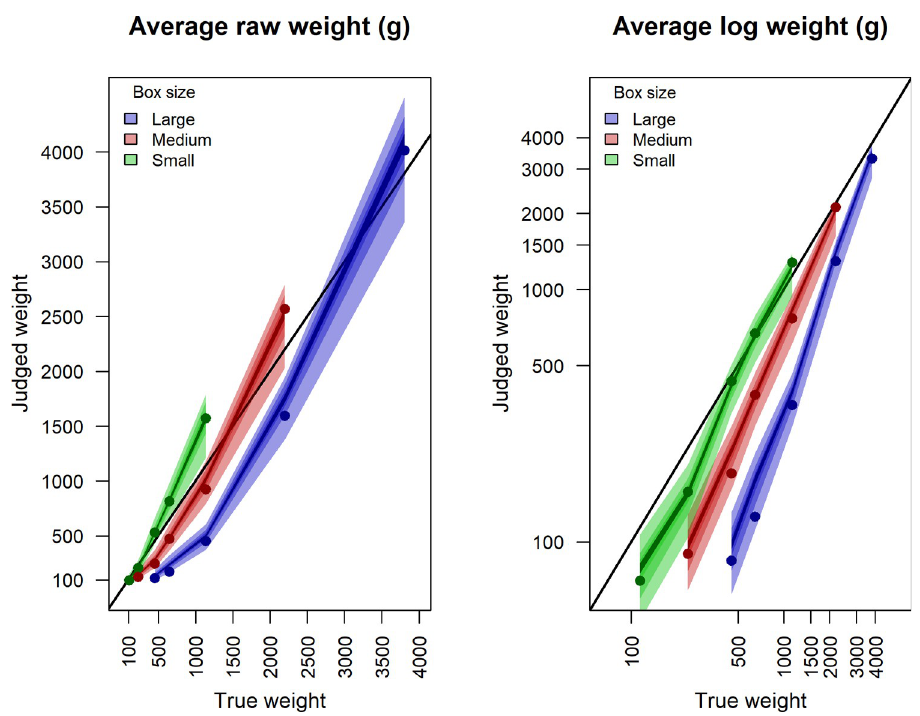
Fig 3. Average judgment of each box’s weight. Points illustrate average point estimates and the colored fields boundaries are determined by the average upper boundary judgments and lower boundary judgments of the self- selected intervals. The colored fields become darker with each consecutive split of the intervals. Hence, the lightest color indicates the average width of the first interval (widest) and the darkest color indicates the average width of the fourth and final interval (most narrow). The aggregate results are stable across sessions, shown in the appendix with plots similar to Fig 3, but for each separate session. Importantly, there was great individual variability in the judgments, shown with figures for each participant, in the